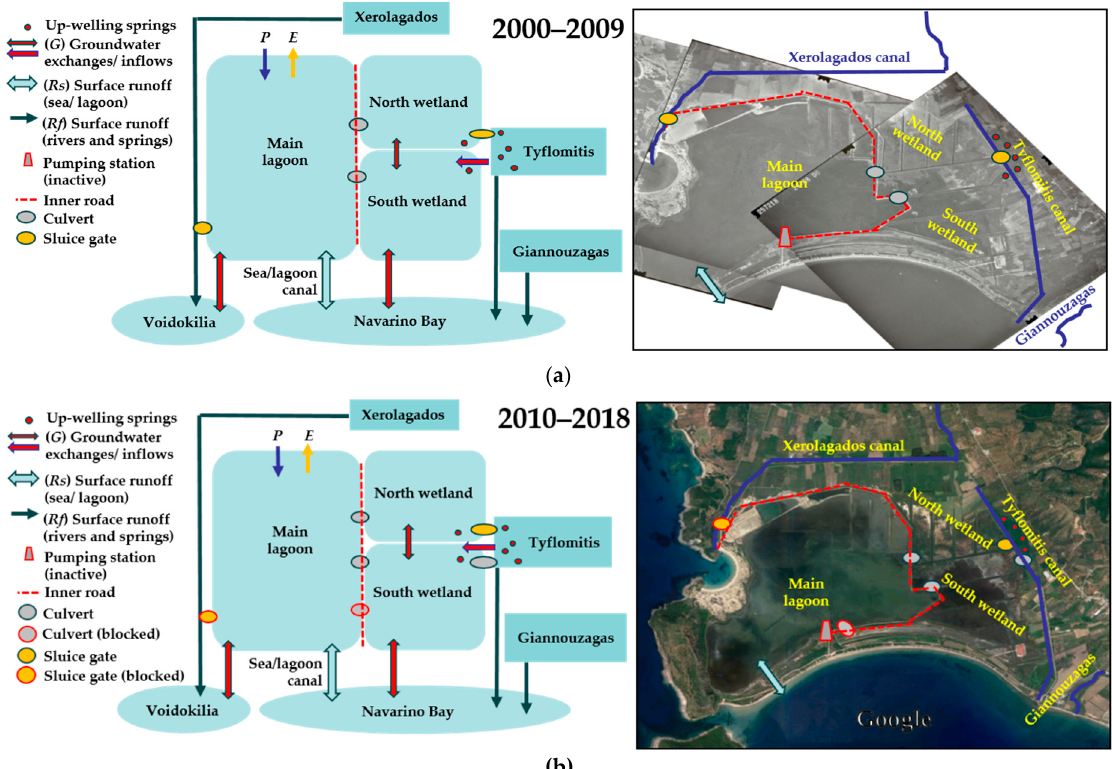
Figure 5. Schematic representation of the hydrological conditions in the GLw-Natura2000: ( a ) during the period 2000–2009 period based on a b/w aerial photograph from 2000, and ( b ) from 2010 to today based on a Google Earth image.